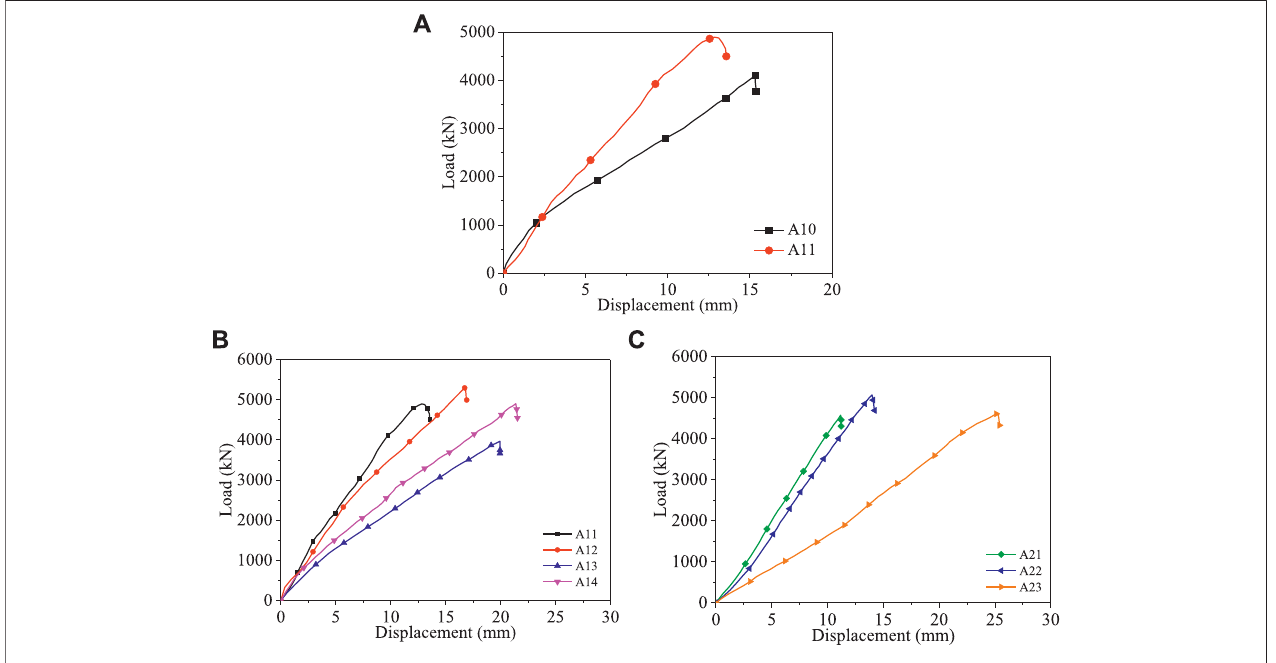
FIGURE 5 | Load-displacement curves of tested specimen. (A) Specimens A10 and A11 (B) Concrete series A1 (C) Concrete series A2.